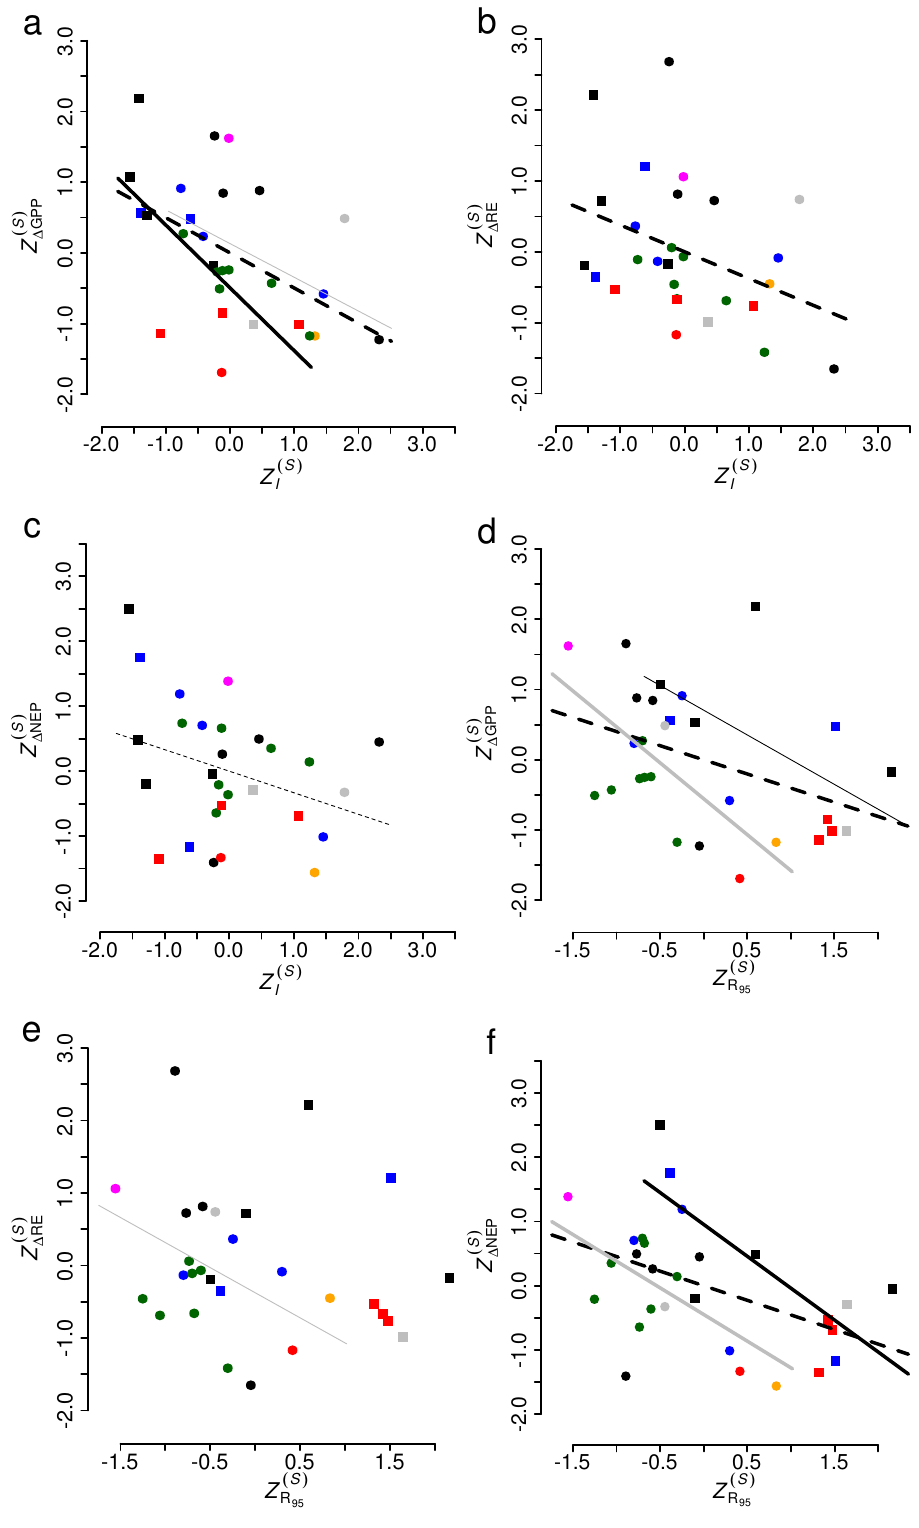
Fig. 4. Site-level standardised annual ecosystem flux residuals ( Z (S) point represents mean conditions for a single site (“dry” sites as squares, “wet” as circles, colour-coded by the IGBP ecosystem type: grey – CSH, green – DBF, blue – EBF, black – ENF, magenta – MF, orange – SAV, red – WSA). Lines show linear regressions significantly different from zero at the 5% (thick lines) or 10% (thin lines) level, solid lines for the “dry” (black) and “wet” (grey) groups separately and dashed lines for the whole data